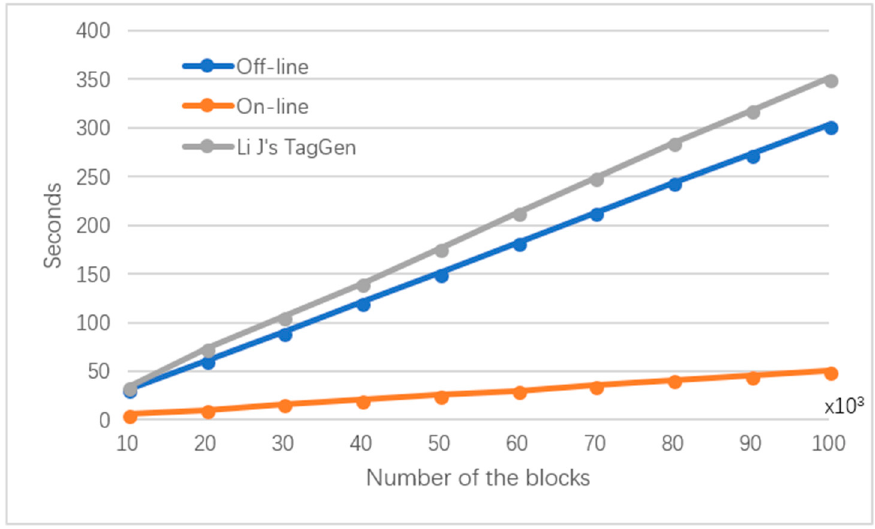
Figure 3. Tag generation time for increased number of data blocks.